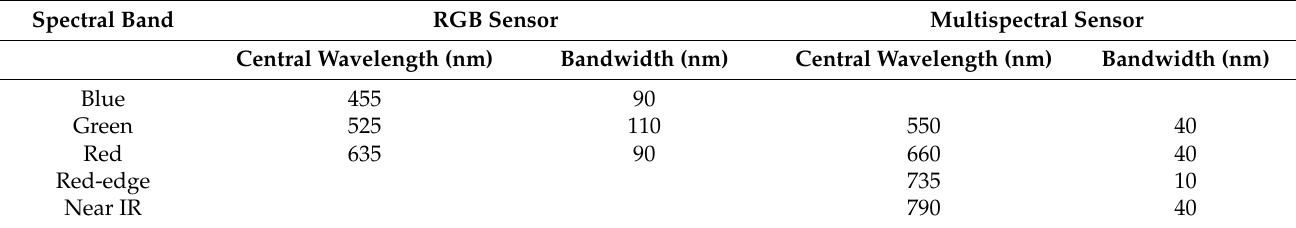
Table 4. Spectral bands for the Parrot Sequoia UAV